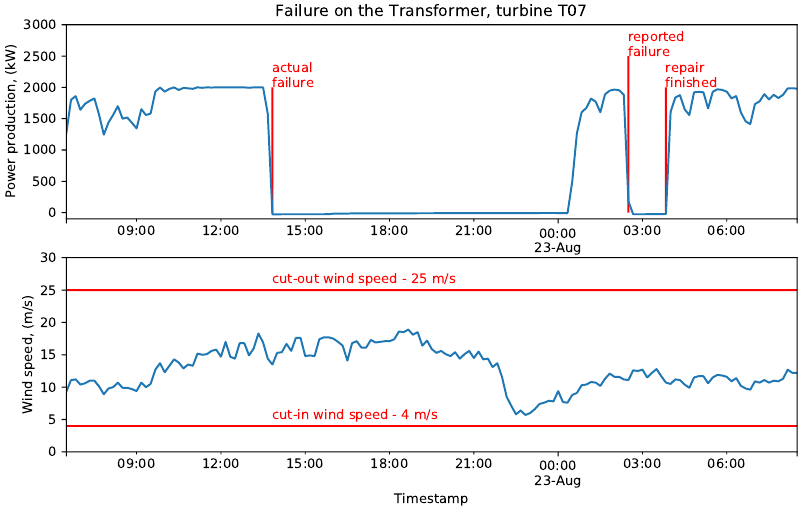
Figure 10. An example of the late report of a